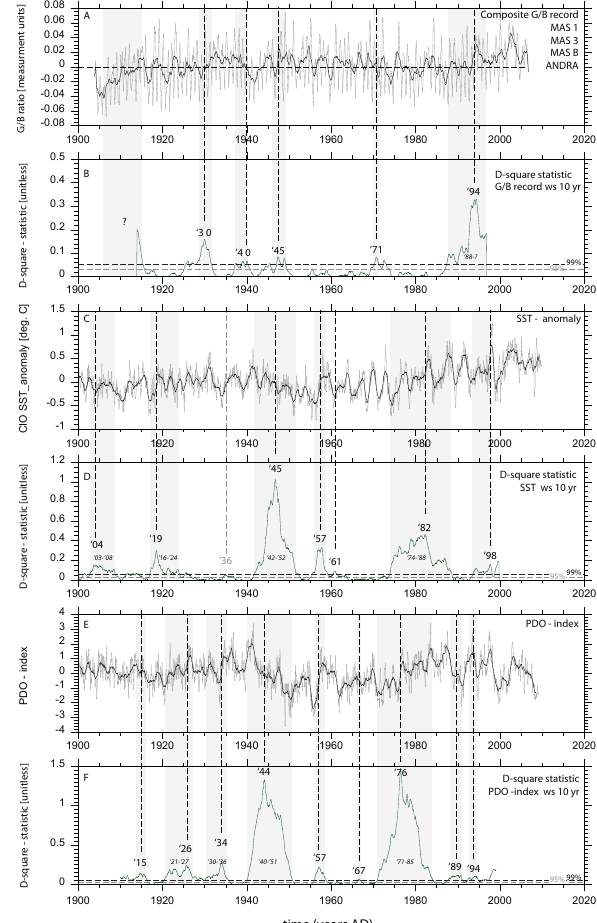
Fig. C1. Record segmentation of the 4 core composite G/B record (MASB, MAS1, MAS3 and ANDRA), PDO index and south CIO ERSST (Smith et al., 2008). (A) shows the raw G/B composite record with a 13 point smoothing superimposed, (C) the south CIO ERSST data with a 13 point smoothing superimposed, and (E) the raw PDO time series with a 13 point smoothing superimposed. The change points (green) which are above the 99% (black dashed) and 95% (grey dashed) significance level are shown for G/B (B) , the PDO index (D) and south CIO ERSST (F) . Major change points are indicated by years and transition periods by grey bands. The first and last 10yr cannot be used for